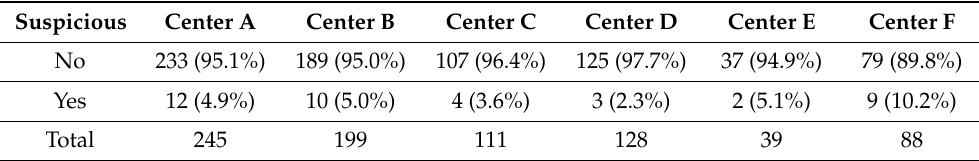
Table 3. Distribution of suspicious cases according to examiner’s subjective impression in each participating center.